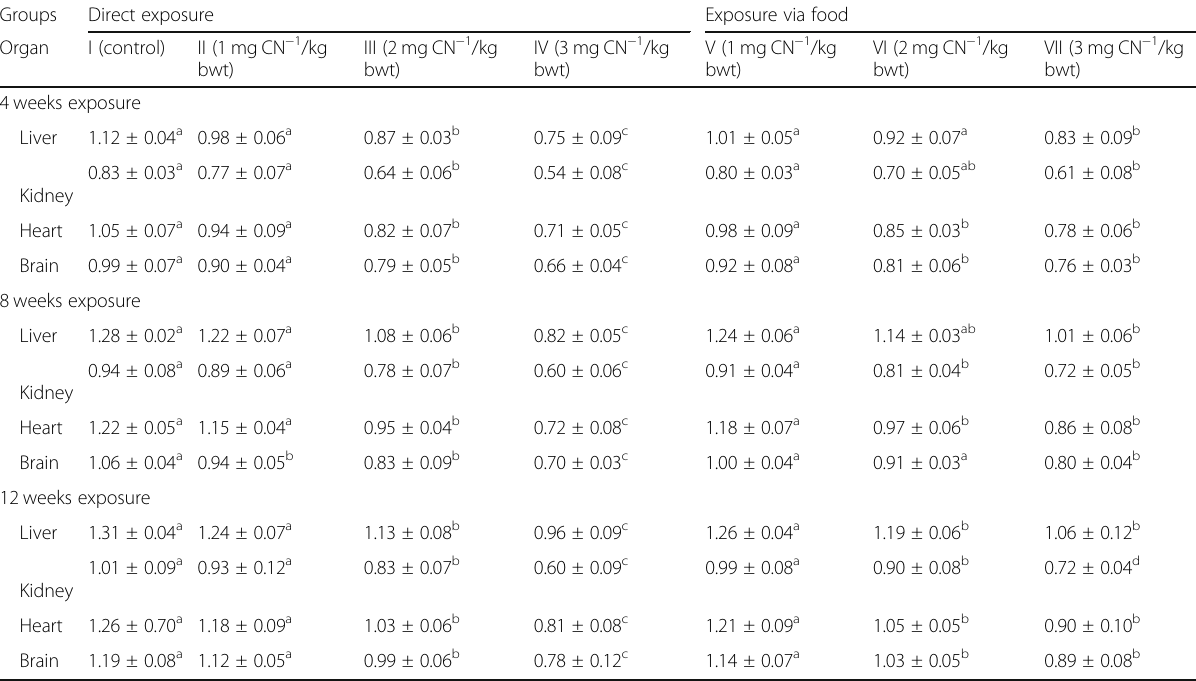
Table 4 The activity of catalase in some organs of birds exposed to cyanide directly and in their feed Groups Direct exposure Exposure via